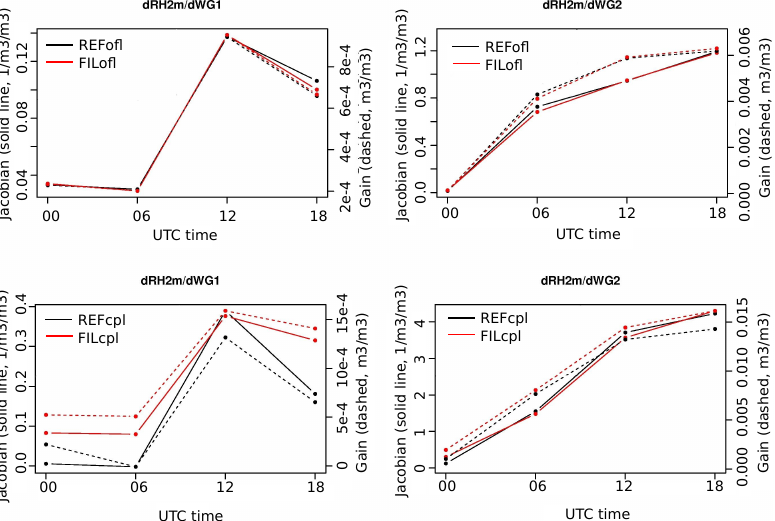
Figure 10. Jacobian and gain values for δ RH 2m /δW s and δ RH 2m /δW 2 averaged over the whole domain on 2 July 2010 for REFofl, FILofl, REFcpl and FILcpl for 00:00, 06:00, 12:00 and 18:00UTC. The solid lines represent the Jacobian values (values on the left vertical axis), and the dashed lines represent the gain values (values on the right vertical